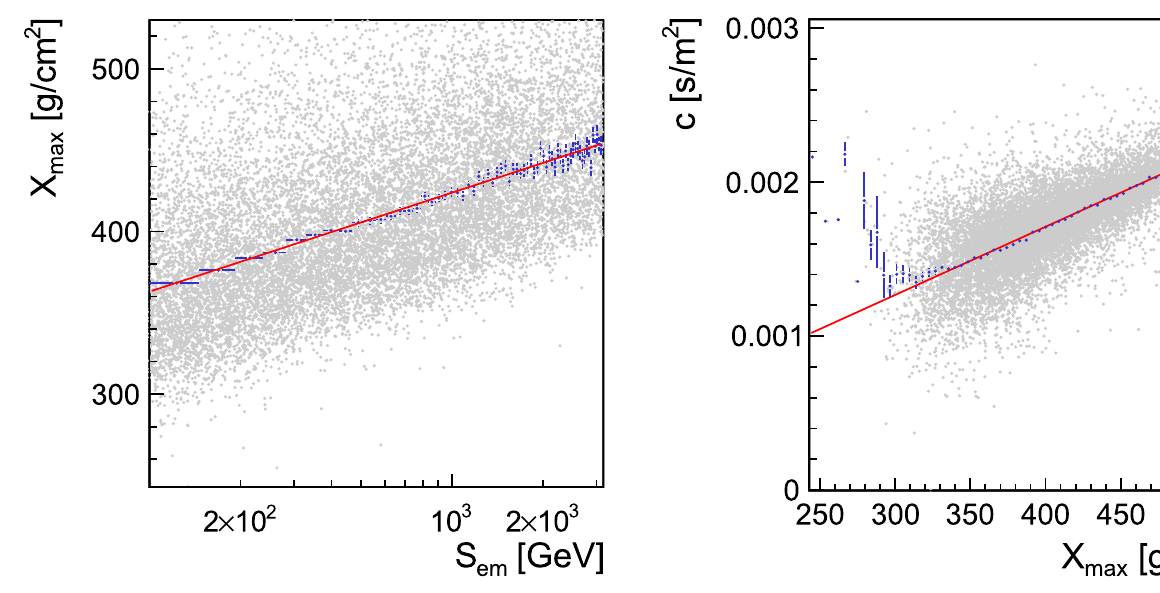
Fig. 5 Correlationoftheslantdepthofthemaximumoftheairshower longitudinal profile, X max , with the energy deposited at the ground, S em (see text for the simulation details)